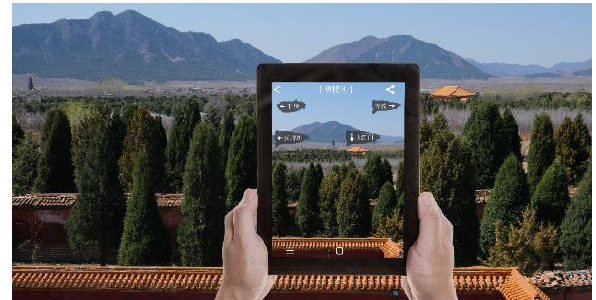
Figure 50. The other mausoleums’ name on the